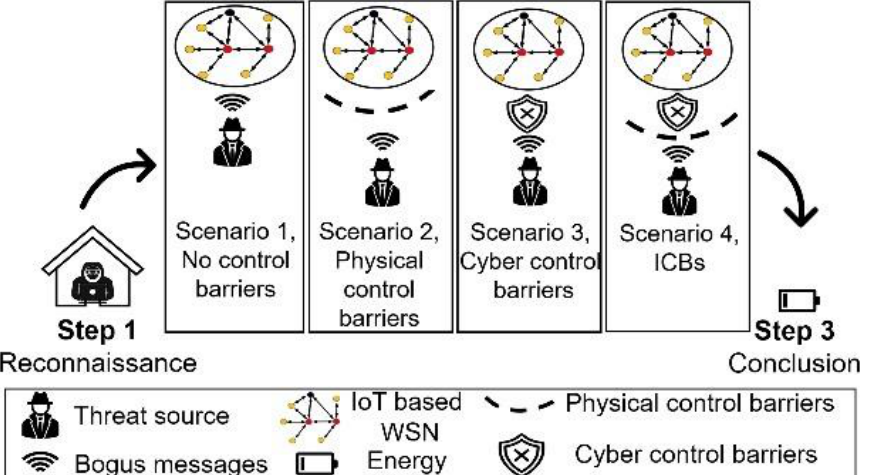
Figure 3. Four scenarios of energy depletion attack against IoT based WSN.